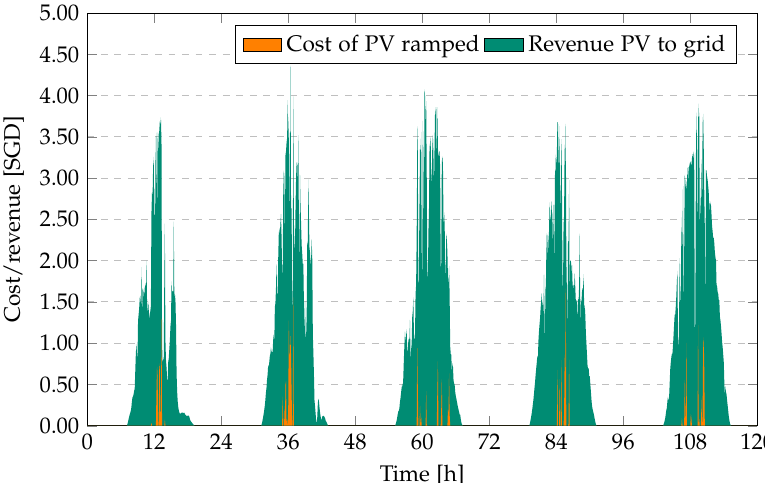
Figure 3. Revenue PV to grid (SGD) and cost of PV ramped (SGD) at 10% ramp requirement over a period of five